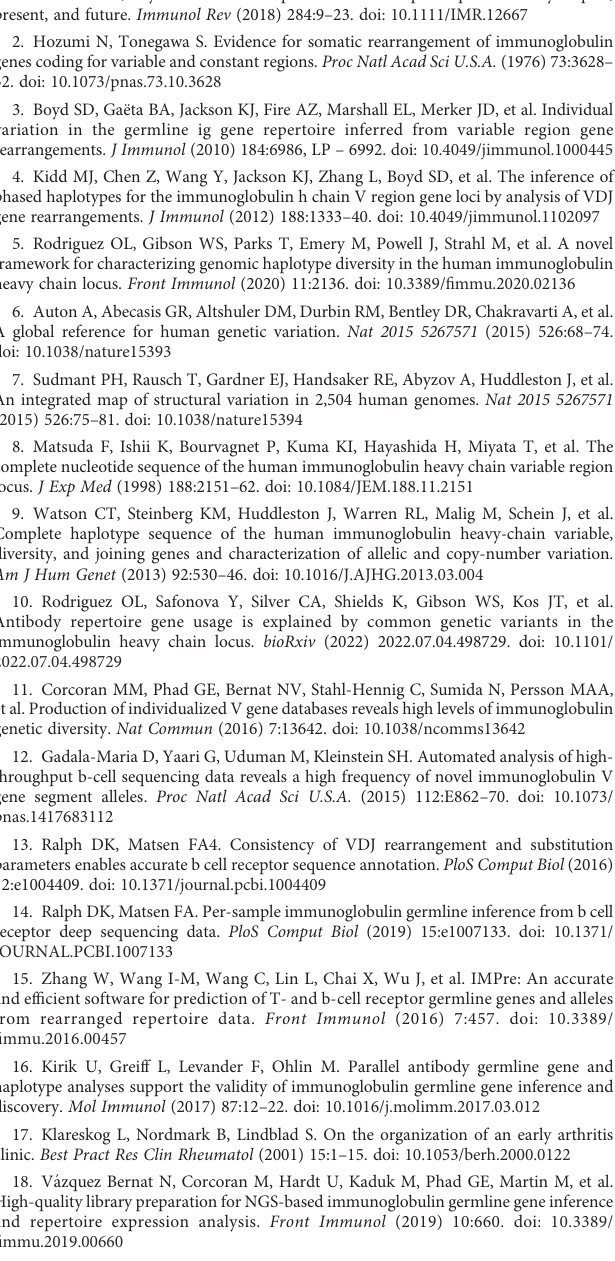
SUPPLEMENTARY FIGURE 1 Restriction digestion of a PCR product comprising the variant position identi fi ed